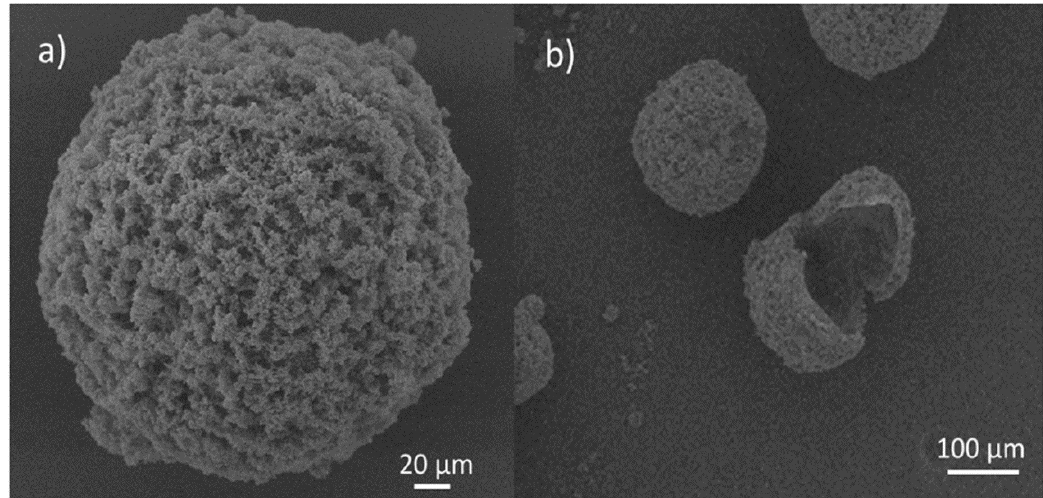
Figure 17. ( a ) SEM image of urea-formaldehyde epoxy capsule ( b ) Cross-section of ruptured capsule shell [193].